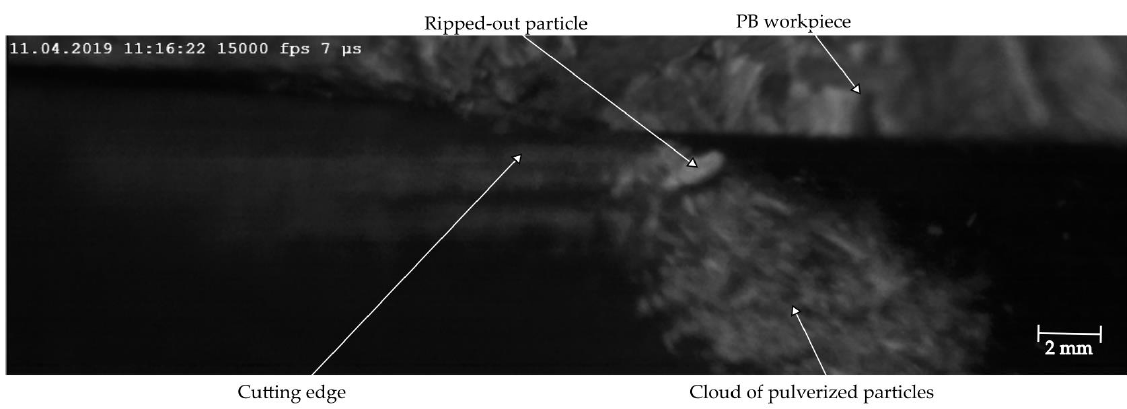
Figure 11. An oversized particle ripped out from the PB structure at the final stage of chip formation is removed within the cloud of small pulverized particles coming from a single uncut chip.